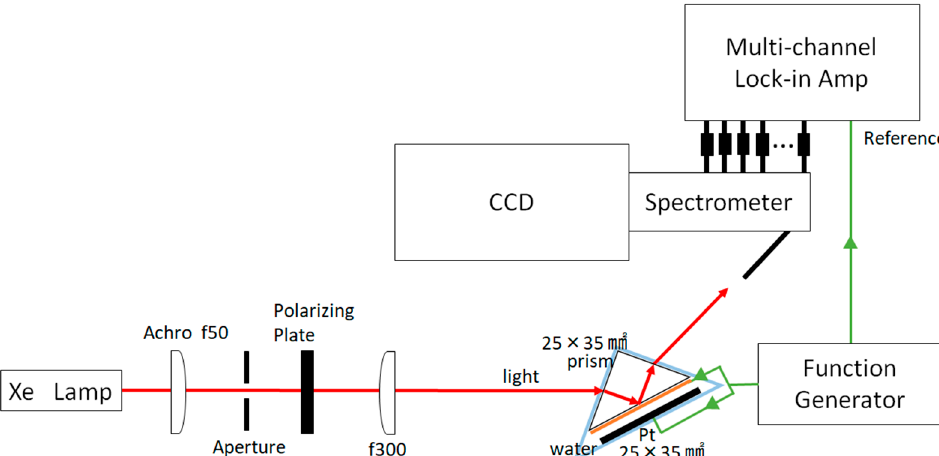
Figure 1. Experimental setup with a cooled Spectrometric CCDs for measurement of reflection spectra and with a multi lock-in amplifier for measurement of electromodulation spectra Δ𝑅 using the function generator. 𝑅 for normalization of Δ𝑅 was measured by intensity-modulationg the reflected probe with a chopper (not shown).